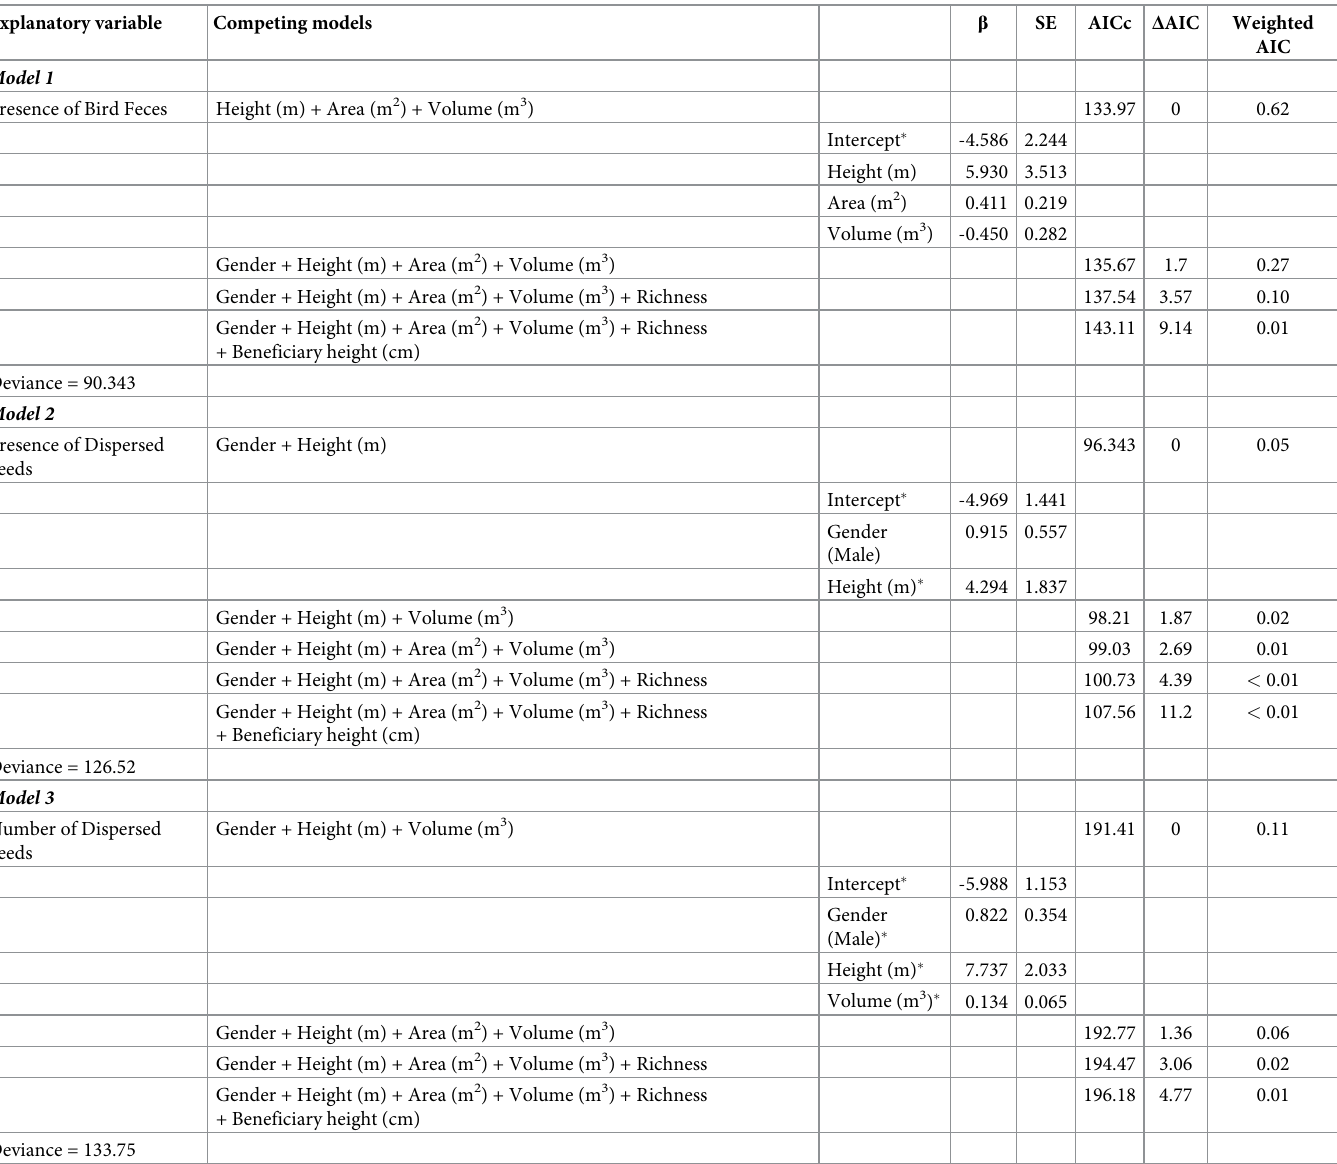
Table 2. GLM carried out to analyze the palm traits in the early-successional